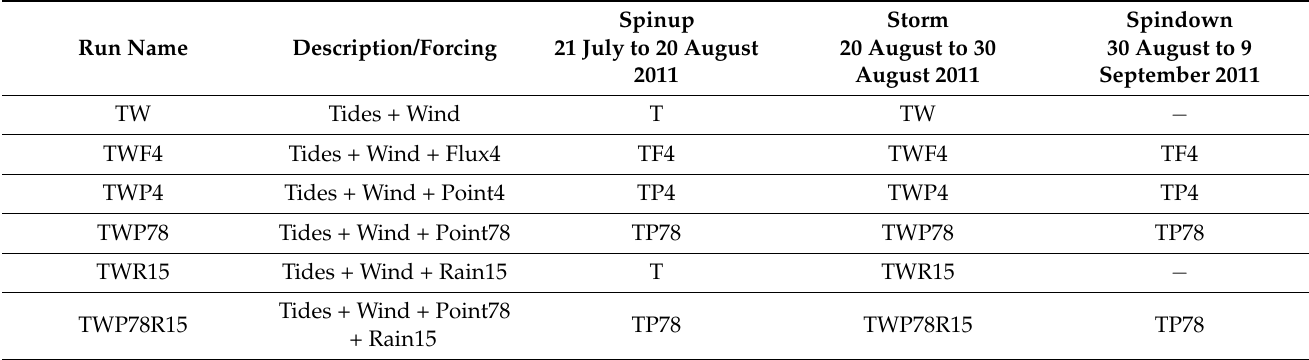
Table 3. Summary of model setup and naming conventions for validation